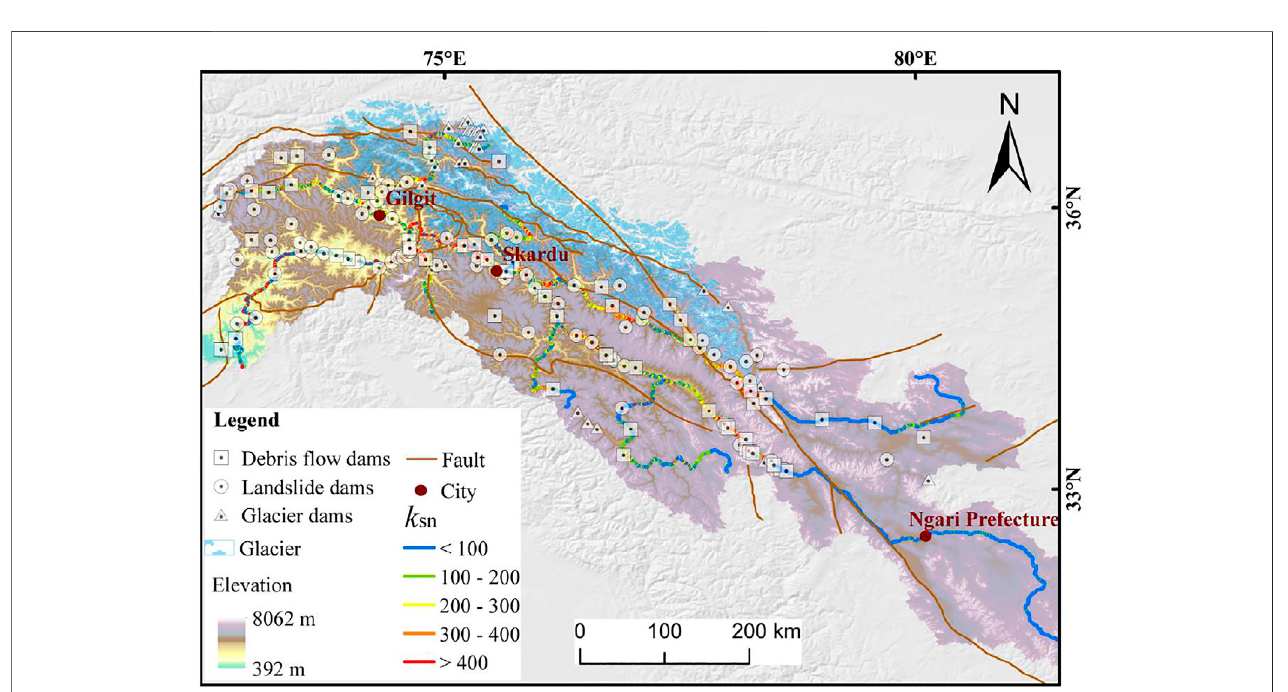
FIGURE 5 | Spatial distribution of dams in the upper Indus River as identi fi ed from remote sensing interpretation.